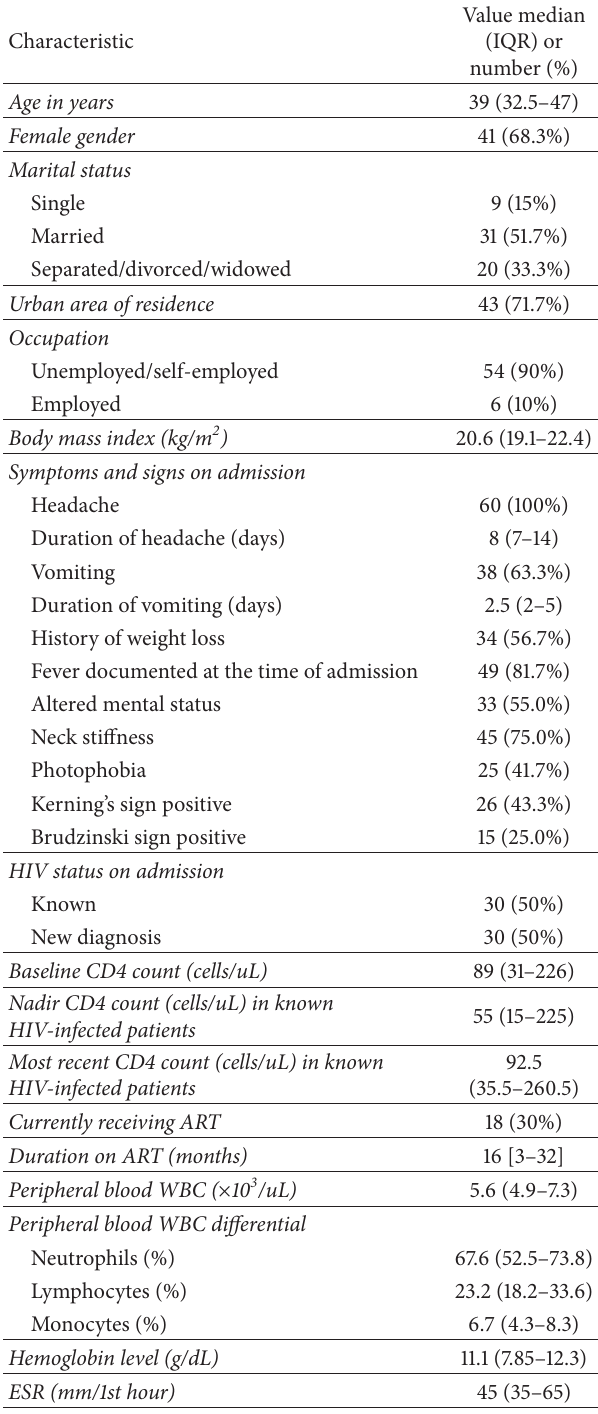
Table 1: Baseline demographic and clinical characteristics of HIV- infected adults admitted with features of meningitis to the medical wards of Bugando Medical Centre between November 2012 and May 2013 ( 𝑛 = 60